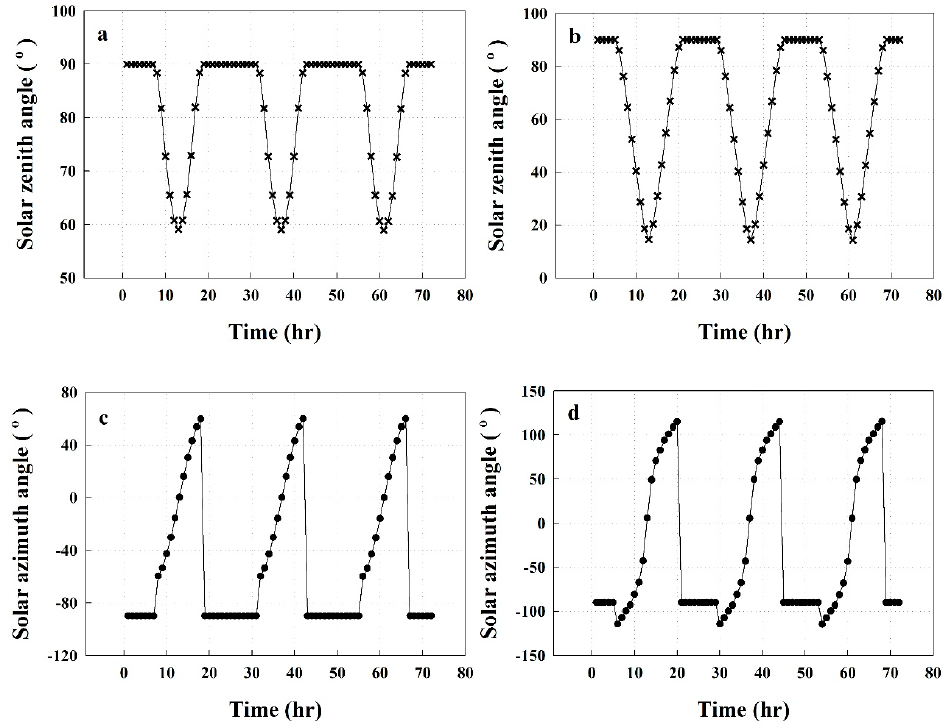
Figure 7. Solar azimuth in ( a ) January, ( b ) June, and zenith angles in ( c ) January, ( d ) June.